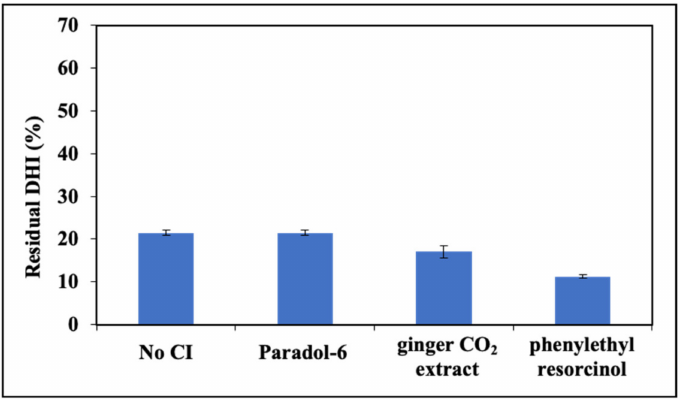
Figure 4. Residual concentration of DHI after 1 h photoirradiation in the presence of 1 µ M pPIX and selected CIs (paradol-6, ginger CO 2 extract and phenylethyl